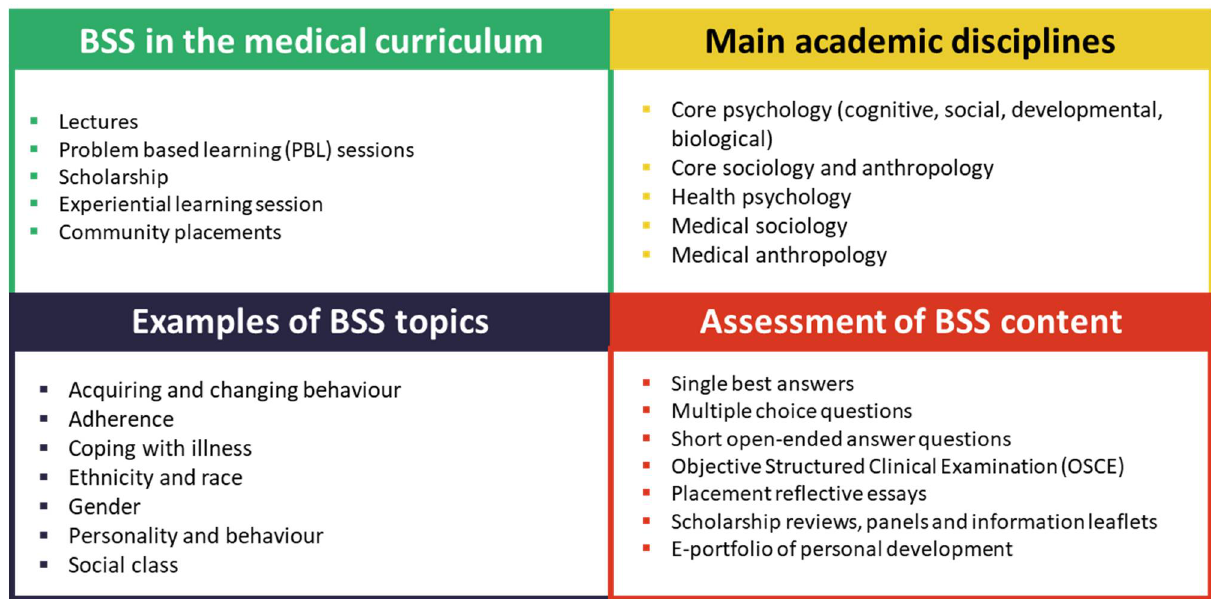
Figure 4. Behavioural and social sciences in the undergraduate medical curriculum.